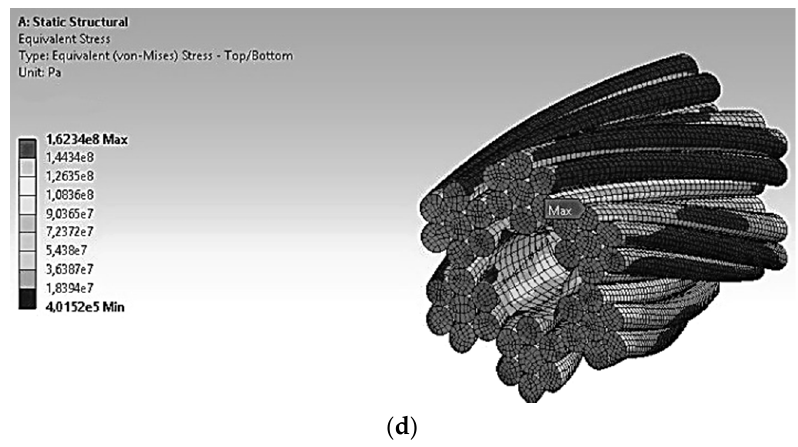
Figure 4. 6 × 7 wire rope with ( a ) full cross ‐ section area; ( b ) one wire suppressed; ( c ) one strand suppressed; ( d ) full cross ‐ section and stress distribution.